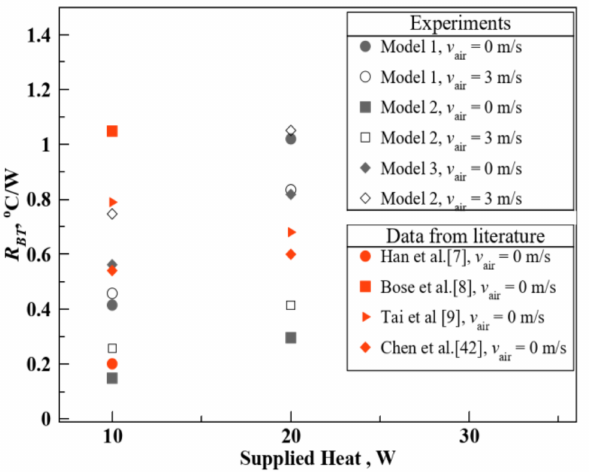
Figure 12. Comparison of the thermal resistance between the present HSVC and those reported in the